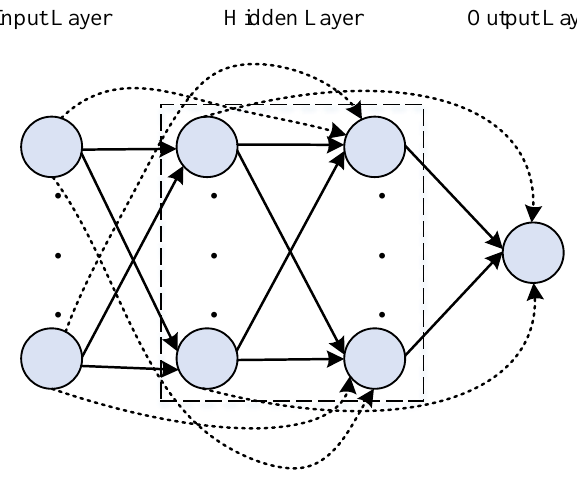
Figure 8. The structure of the cascade-forward multilayer neural network.